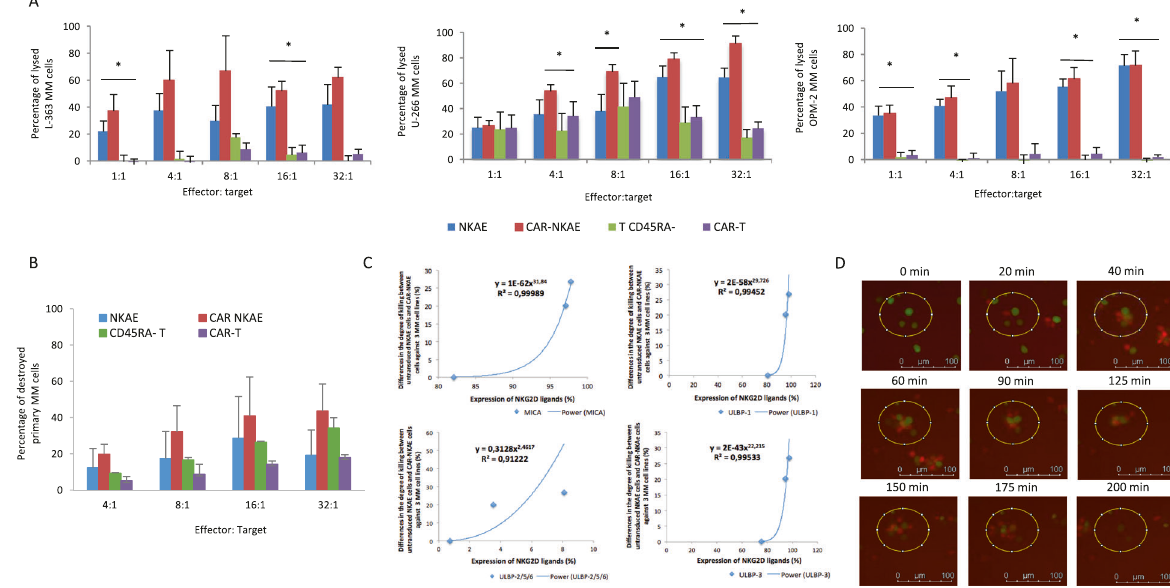
Fig. 4 Antimyeloma activity of CAR-NKAE and memory CAR-T-cell products. A Cytotoxic activity of untransduced NKAE cells and memory T cells (CD45RA − T cells), CAR-NKAE cells, and memory CAR-T cells against different MM cell lines. Results are shown as mean ± SEM of four independent experiments. * P < 0.05 compared to untransduced cells (NKAE and memory T cells) and memory CAR-T cells. B Cytotoxicity of NKAE and CAR-NKAE against primary MM cells from bone marrow sample at different E:T ratios (triplicates). C Plots representing the relationship between the differences in the degree of killing (between NKAE cells and CAR-NKAE cells) and the expression of NKG2DL (MICA, ULBP-1, ULBP-2/5/6, and ULBP-3) in 3 MM cell lines with different expression of NKG2DL. D Time-lapse experiments were performed, U-266 MM cells (green) were destroyed by CAR-NKAE cells (red) with only 20 min of exposure. After 3 h, MM cells were destroyed and released the green fl uorescent